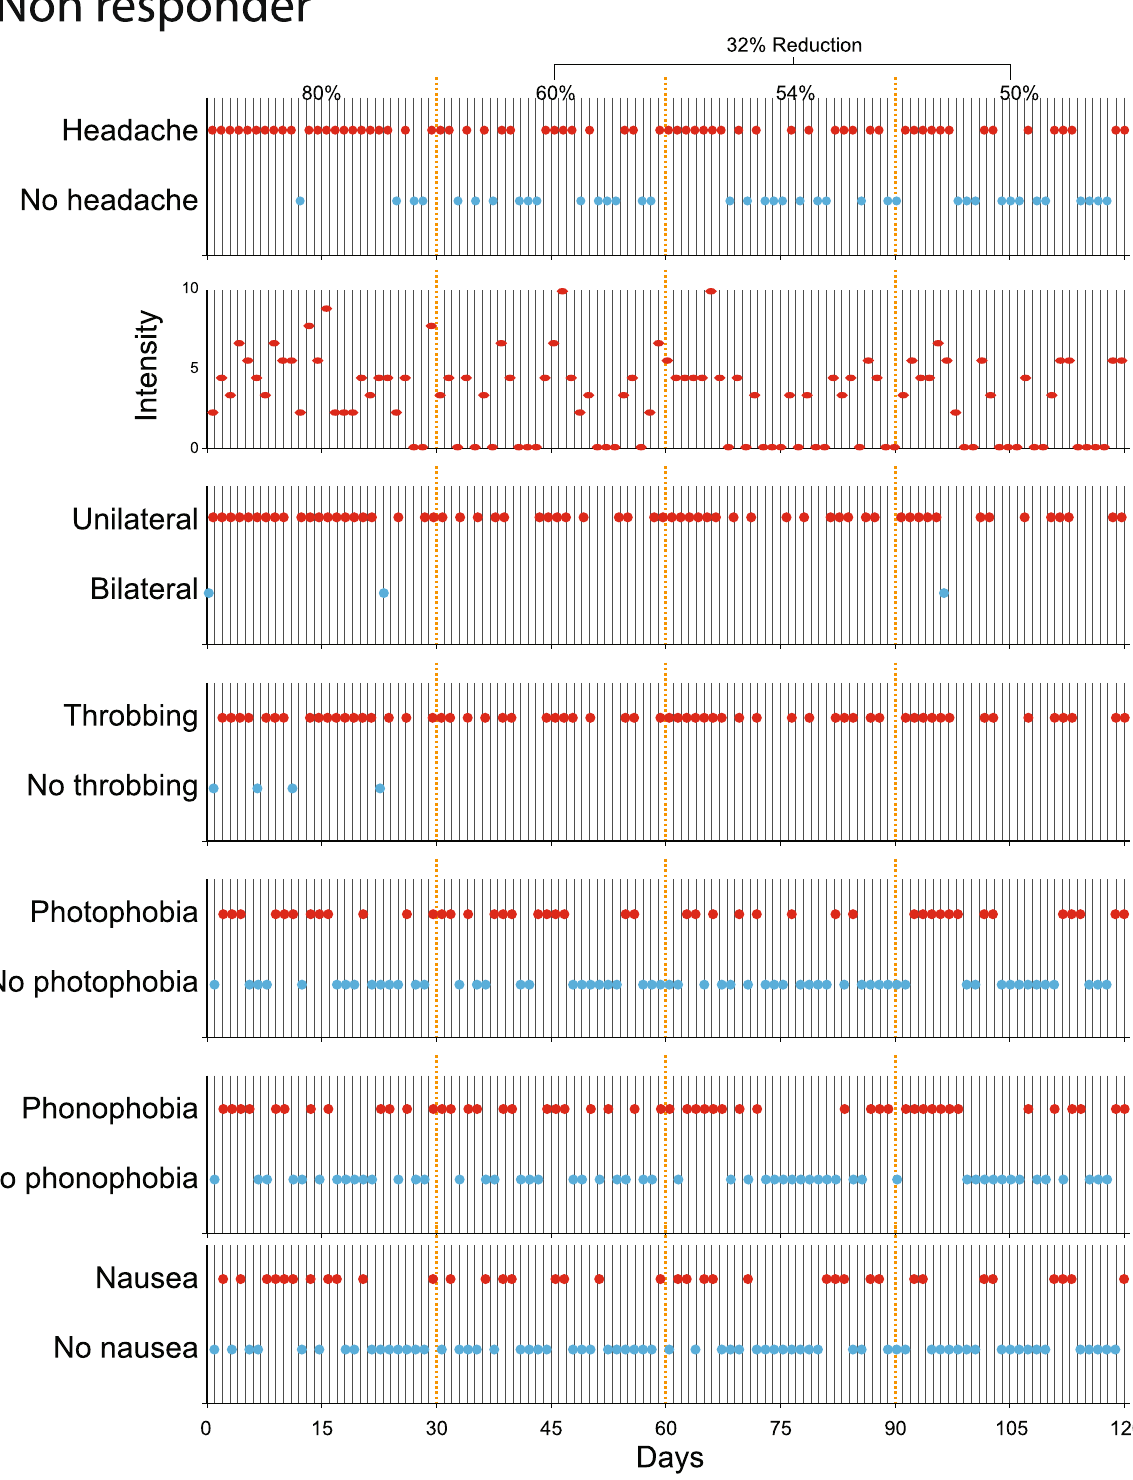
Fig. 3 Identification of galcanezumab non‑responder. Note that the percentage of monthly migraine days (MMD) decreased by < 50% during the treatment period (from 80% before treatment to 54.6% during the 3 months of